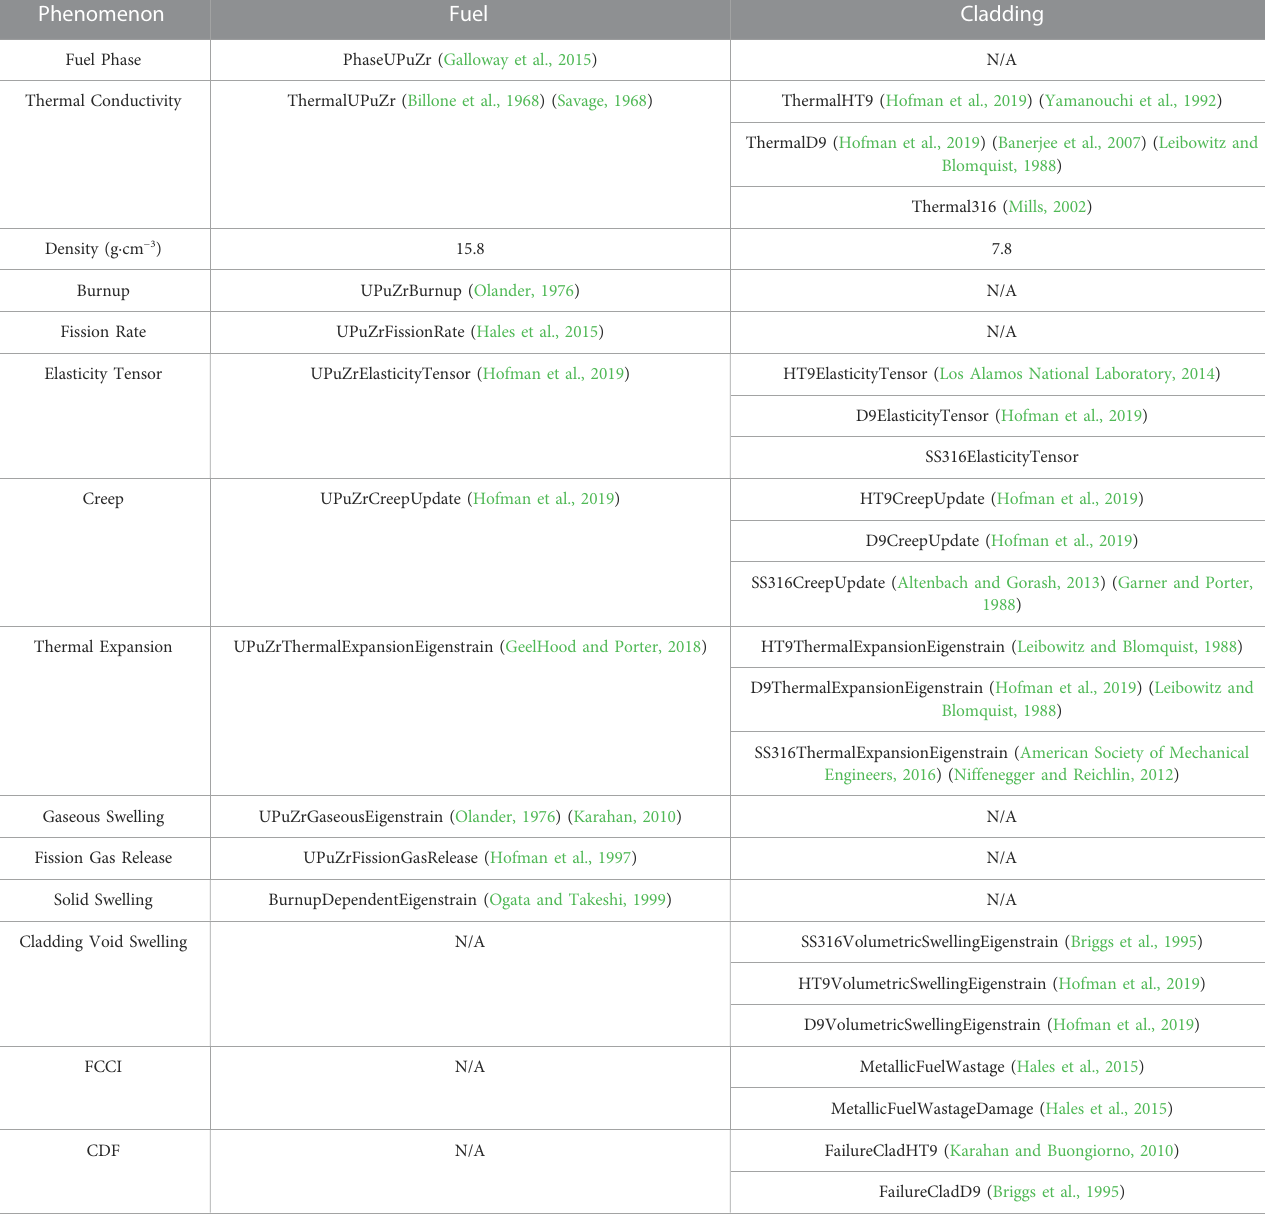
TABLE 3 BISON Objects used in BISON Simulations (Hales et al.,